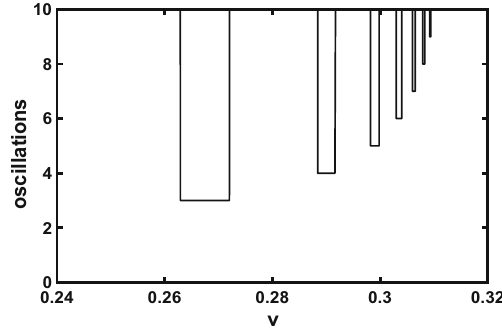
Fig. 12 Number of oscillations during an one-bounce collision as a function initial velocity for n =